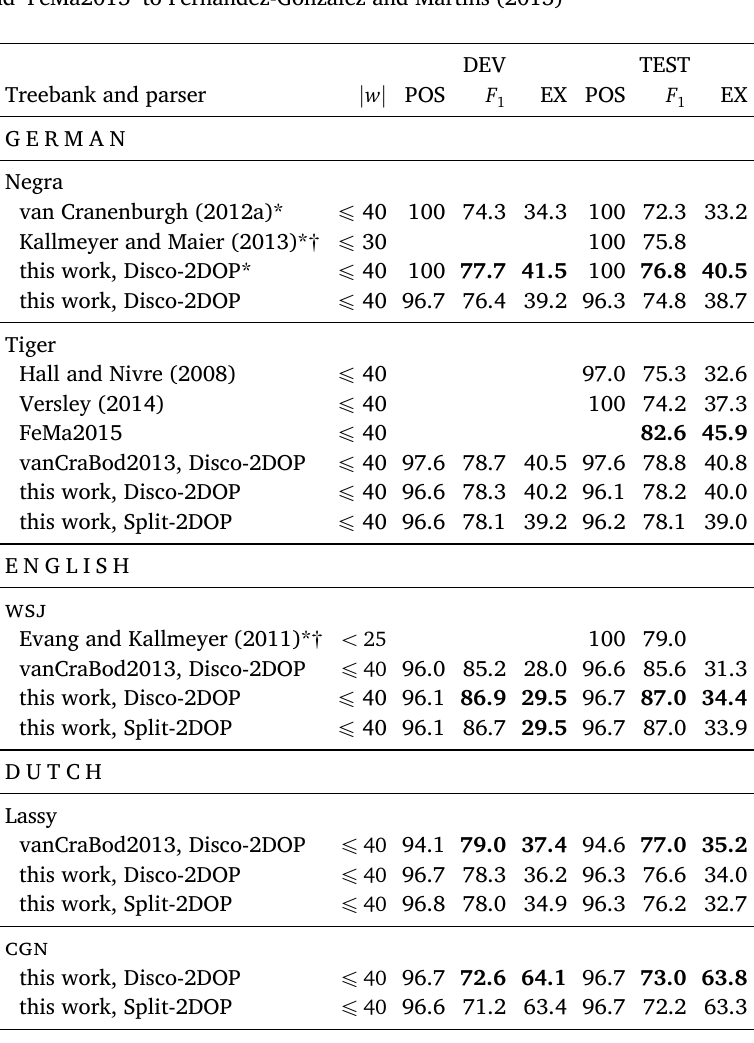
Table 3: Discontinuous parsing of three Germanic languages. POS is the part- of-speech tagging accuracy; F 1 is the labelled bracketing F 1 -score; EX is the exact match score. Results marked with * use gold standard pos tags; those marked with † do not discount the root node and punctuation. NB: Kallmeyer and Maier (2013) and Evang and Kallmeyer (2011) use a different test set and length restriction. ‘vanCraBod2013’ refers to van Cranenburgh and Bod (2013), and ‘FeMa2015’ to Fernández-González and Martins